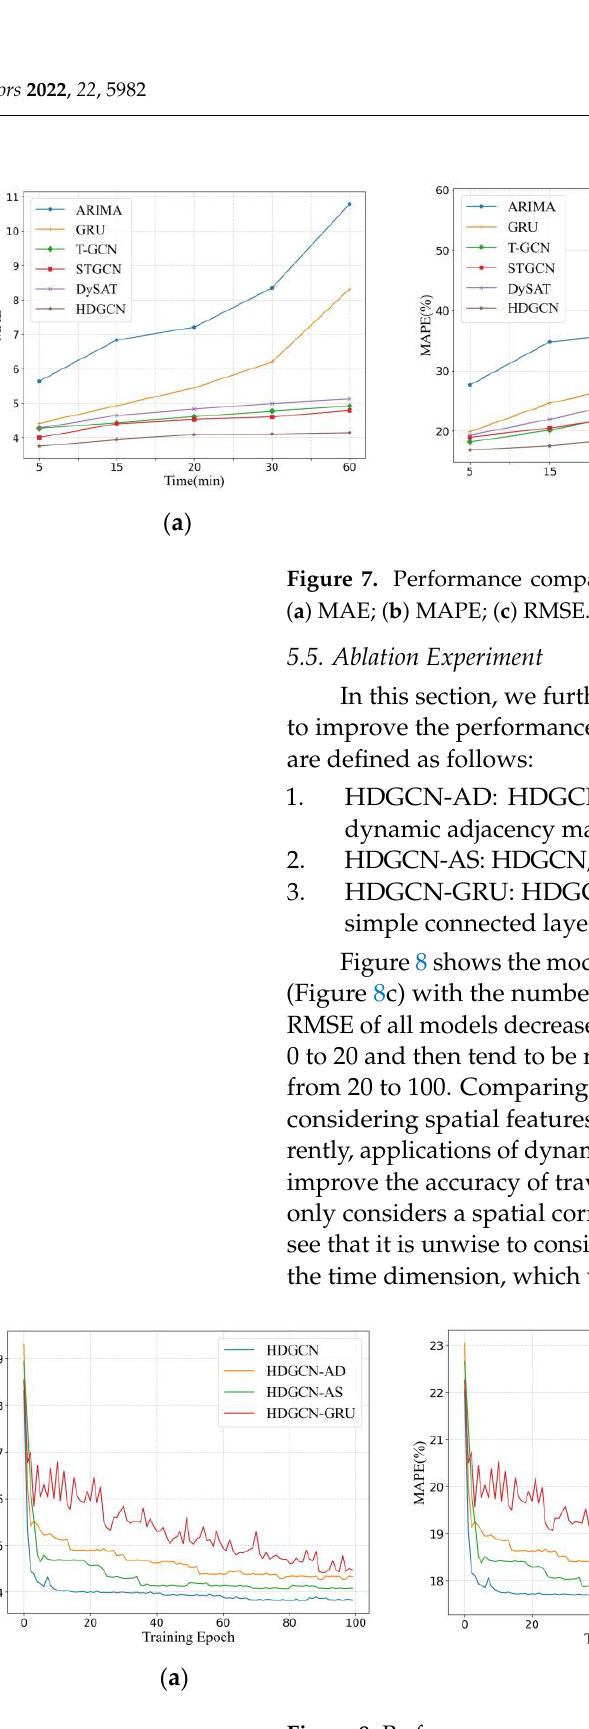
Figure 8. Performance comparison of the HDGCN model and its variants at different epochs on the validation set: ( a ) MAE; ( b ) MAPE; ( c ) RMSE.